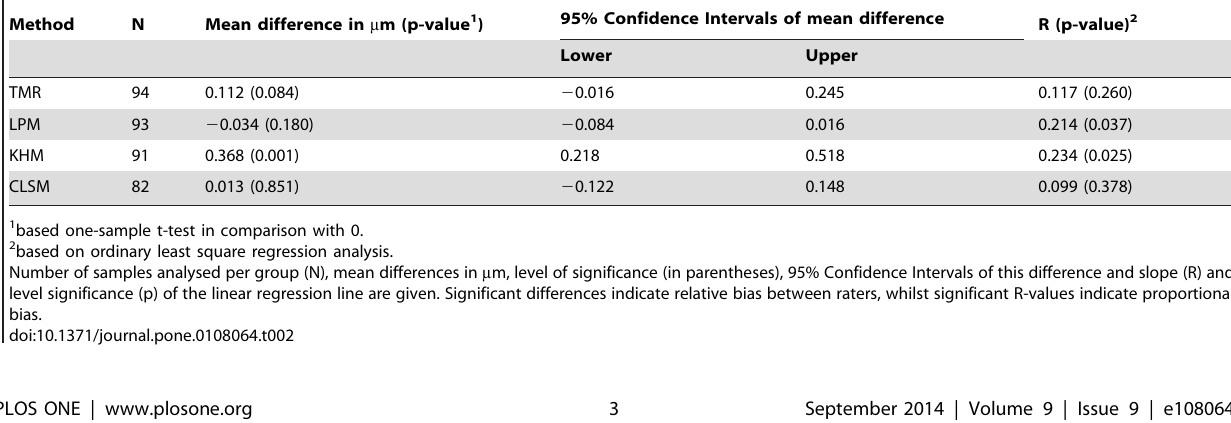
Table 2. Inter-rater agreement.